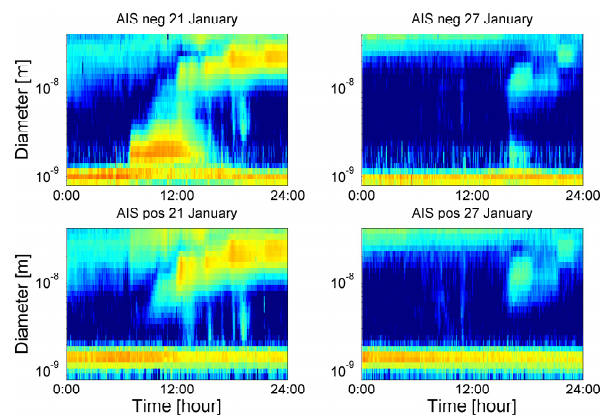
Fig. 8. In the upper panel, the measured HGF values for the four particle sizes as a function of time on 20 and 21 January, 2007. In the lower panel, the aerosol particle and negative ion number size distribution as a function of time measured on 20 and 21 January, 2007. The y-axis shows the size ranging from 0.8nm up to 1µm. Colour presents the concentration. Particle size distributions above 5nm size are measured with the DMPS and below that are the dis- tributions of negative ions measured with the AIS.